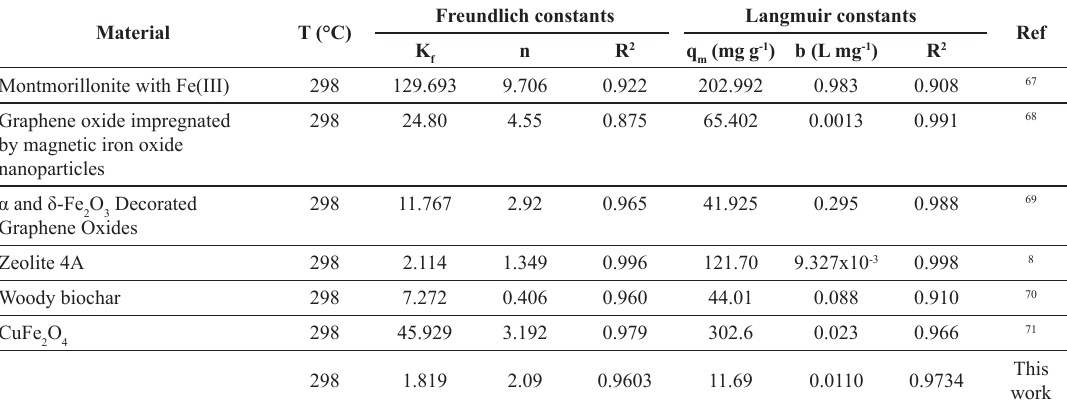
Table 6. Comparison of glyphosate adsorption parameters on some materials. Material